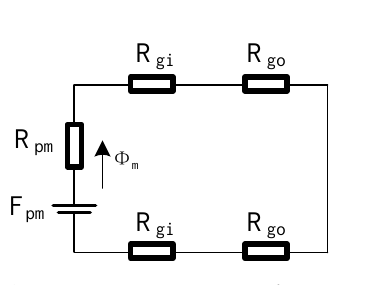
Figure 3. Magnetic circuit of one pole.